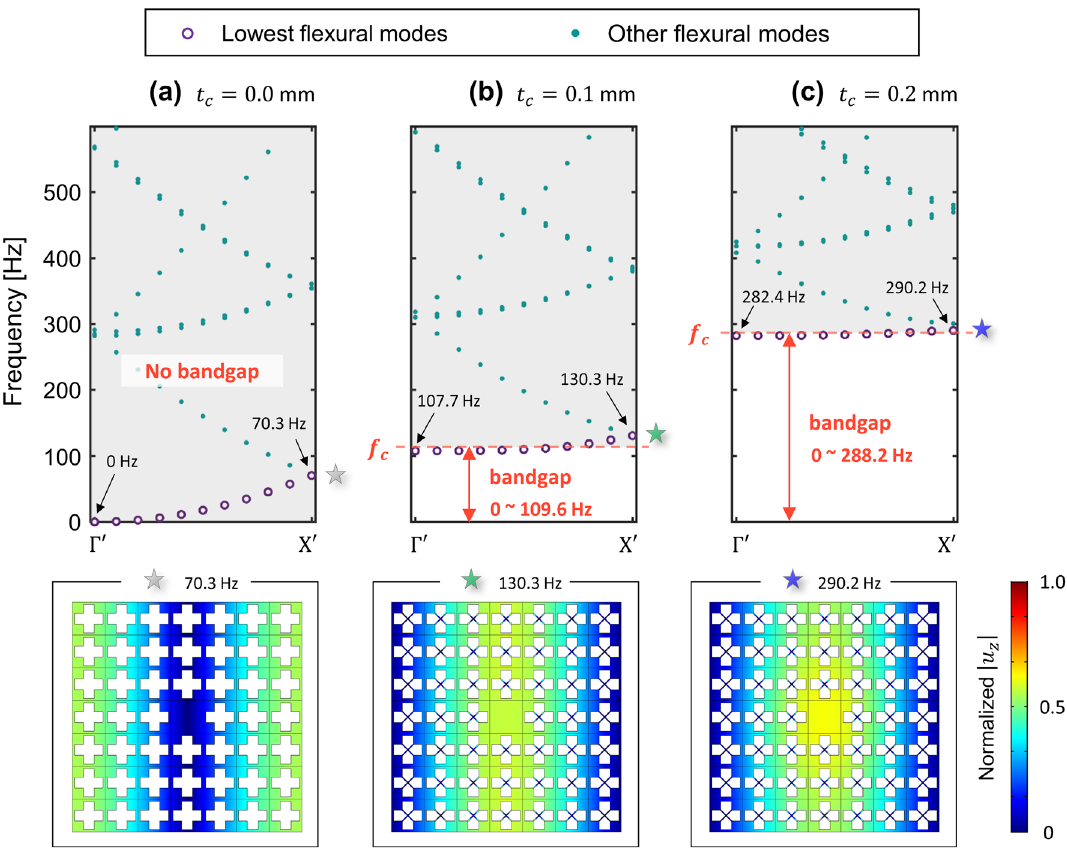
Figure 5. Not localized wave from the supercell analysis. t c is ( a ) 0.0 mm, ( b ) 0.1 mm and ( c ) 0.2